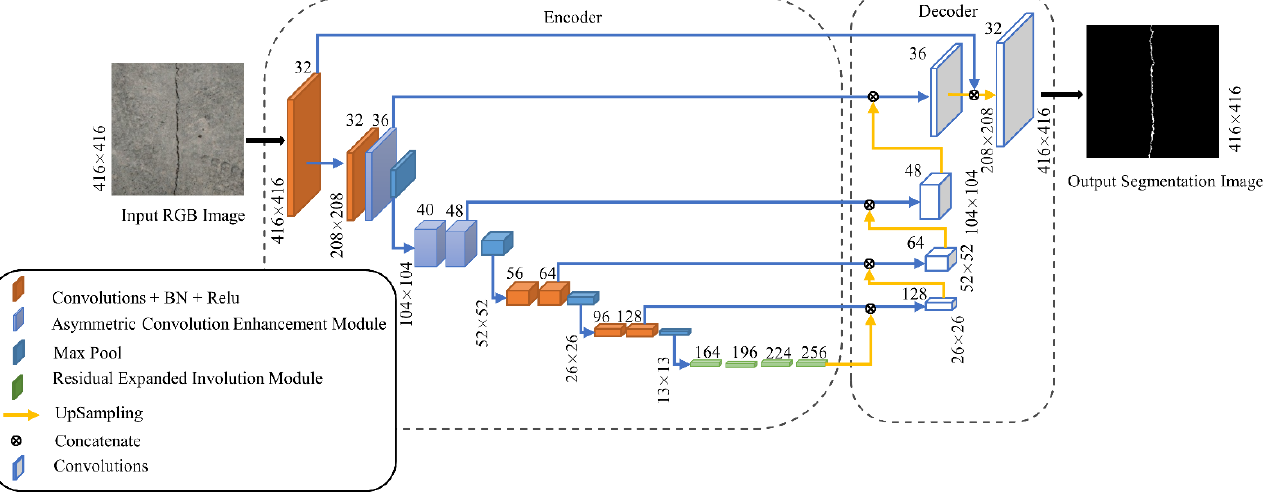
Figure 1. Overall model framework of RIIAnet.